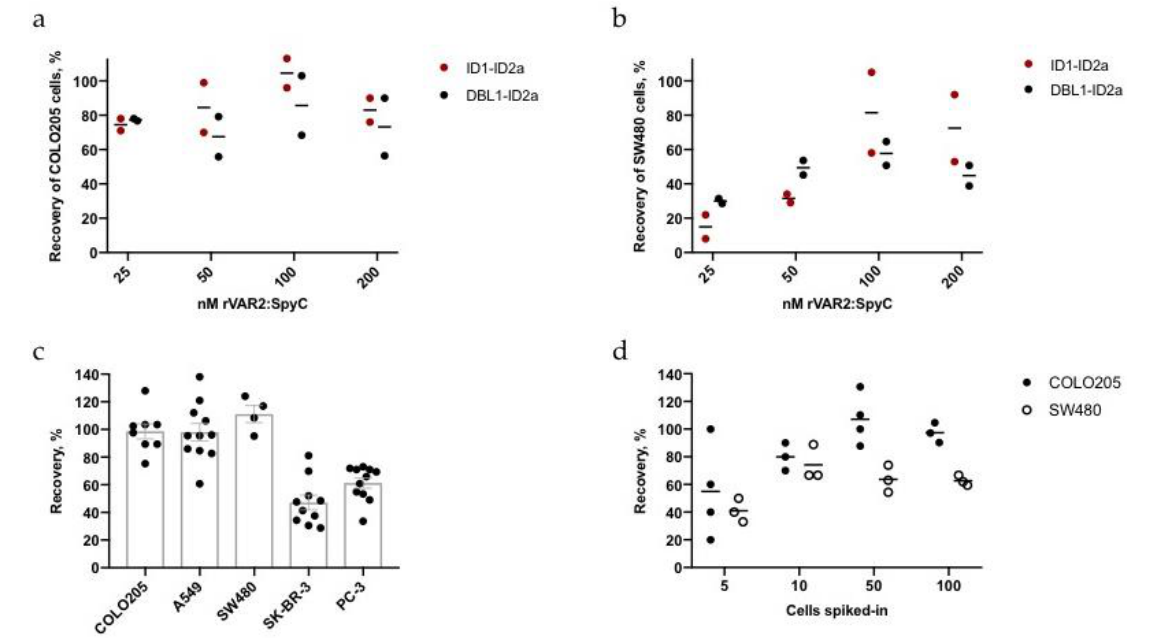
Figure 5. rVAR2-based indirect capture of cancer cells. ( a ) and ( b ) Recovery of 100 COLO205 or SW480 cells spiked into 3 mL blood using 25–200 nM biotinylated rVAR2-SpyC prior to bead incubation. Lines represent mean values of duplicates. ( c ) Recovery of 100 cells for each of the five cancer cell lines COLO205 ( n = 8), A549 ( n = 10), SW480 ( n = 4), SK-BR-3 ( n = 10) and PC-3 ( n = 11) from 3 mL blood samples using 200 nM biotinylated DBL1-ID2a-SpyC prior to bead incubation. Each dot represents a sample recovery and error bars show +/- SEM. ( d ) Sensitivity testing of the indirect capture approach using 200 nM biotinylated DBL1-ID2a-SpyC for the retrieval of approximately 5–100 COLO205 or SW480 cells spiked into 3 mL blood. The exact cell number can be found in Table S3.